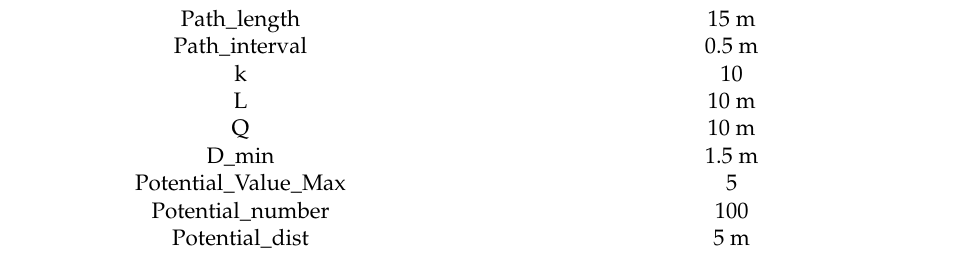
Figure 13. UGV and obstacles: ( a ) obstacles and calculated local path; ( b ) potential field and calculated local path. Table 3. Driving test environment.